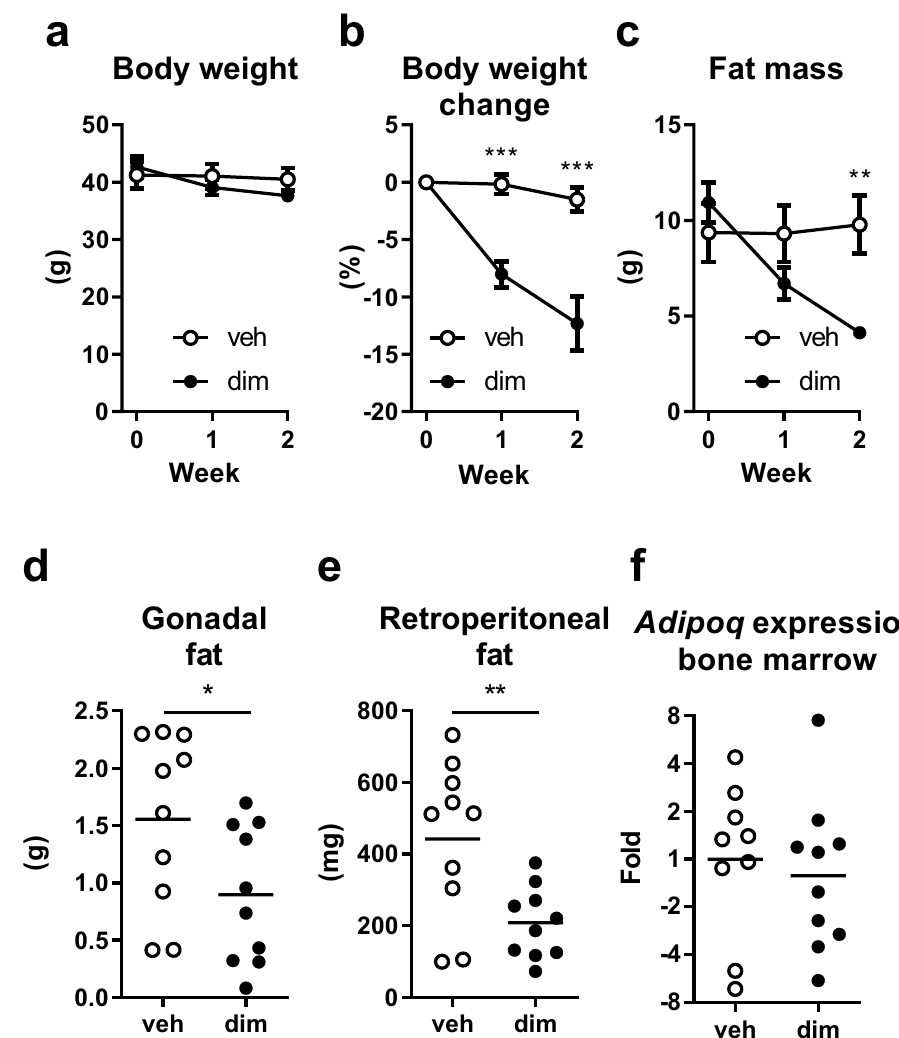
Figure 1. Peripheral fat mass was reduced two weeks after induction of adipocyte apoptosis. ( a ) Body weight, ( b ) percent body weight change, and ( c ) total fat mass, measured by DXA, at 0, 1, and 2 weeks after dimerizer injection. Weight of dissected ( d ) gonadal and ( e ) retroperitoneal fat pads 2 weeks after dimerizer injection. ( f ) Tibial bone marrow adiposity, assessed by gene expression of the adiponectin gene ( Adipoq ) 2 weeks after dimerizer injection. ( a – c ) Data are arithmetic mean ± sem. ( d – e ) Symbols in the scatter plots represent individual mice and the bars indicate arithmetic mean. ( f ) Symbols in the scatter plot represent individual mice and the bars indicate geometric mean. dim, dimerizer; veh, vehicle. n = 10 veh and 10 dim mice, except for ( f ) were n = 9 veh and 10 dim mice, due to laboratory error. ( a – b , d , f ) Student’s t-test. ( c , e ) Welch’s t-test. * P < 0.05, ** P < 0.01, and *** P <